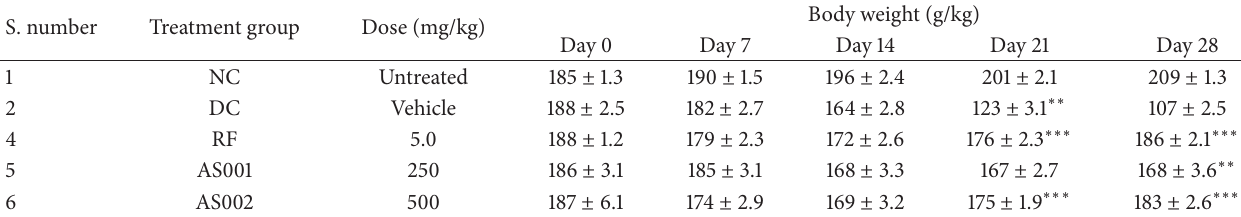
Table 5: Effect of Pupalia lappacea in body weight of STZ induced diabetes in rats. S.